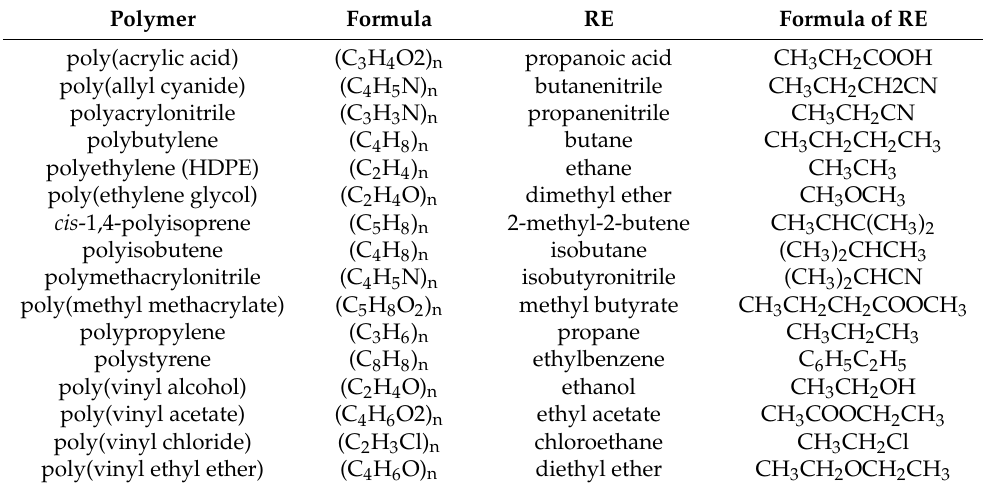
Table 2. Summary of polymer repeating elements (REs) included in the validation set with experi- mental ∆ H vap (see Supplementary Materials, Tables S2 and